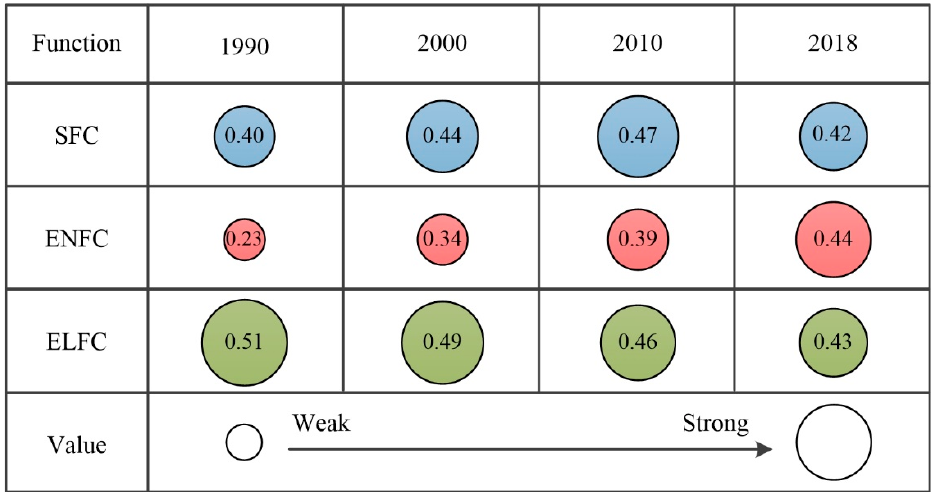
Figure 3. Overall evolution trends of oasis cultivated land functions of Xinjiang from 1990 to 2018.